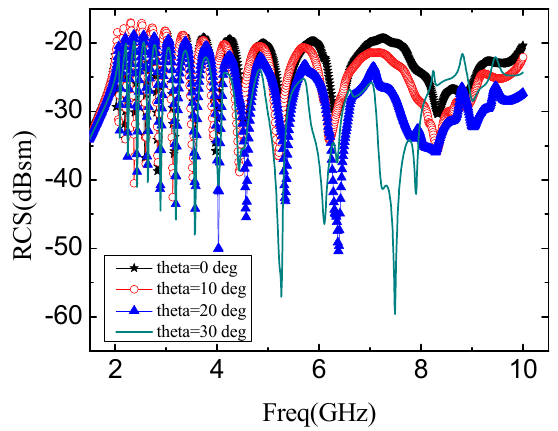
Figure 9. The spectrum of altering θ from 0° to 60° when φ = 0°. The substrate is F4BM.